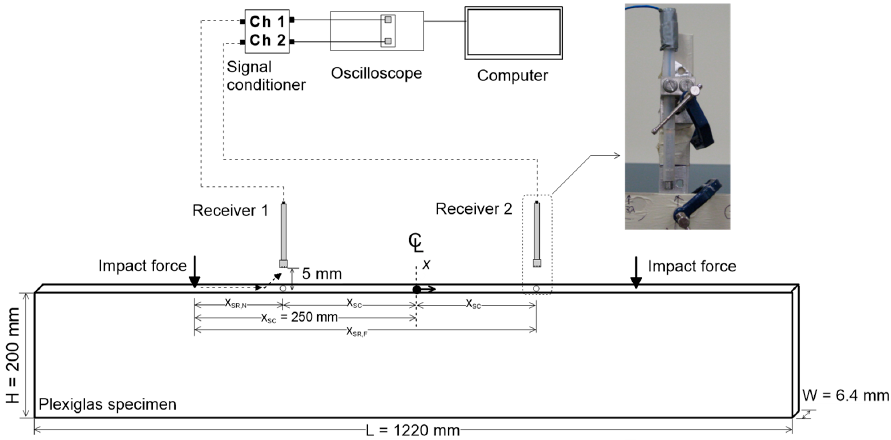
Figure 3. Test setup of air-coupled surface wave measurement in a Plexiglas specimen.